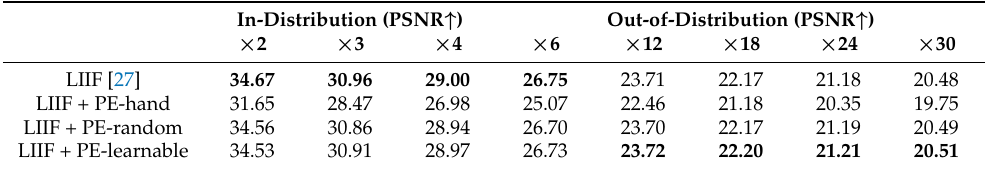
Table 5. Quantitative comparison of three different positional encoding approaches in Figure 3 (PSNR(dB)), the bold in table is the highest